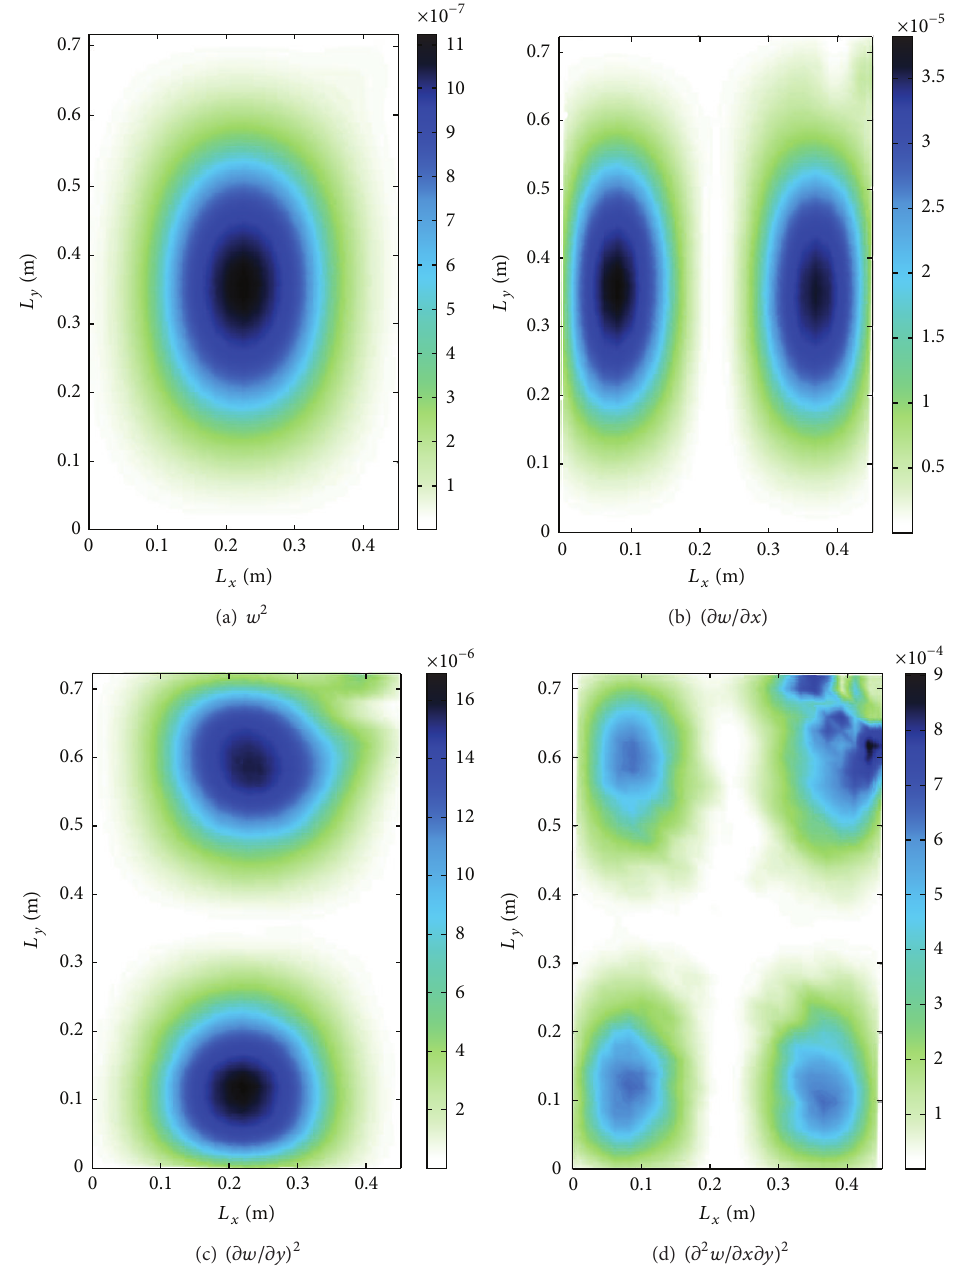
Figure 16: Experimental WSSG terms for the first structural